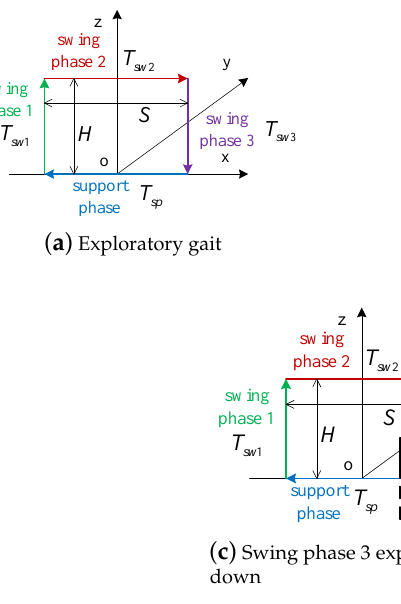
( c ) Swing phase 3 exploring to touch down Figure 5. Principle of exploratory